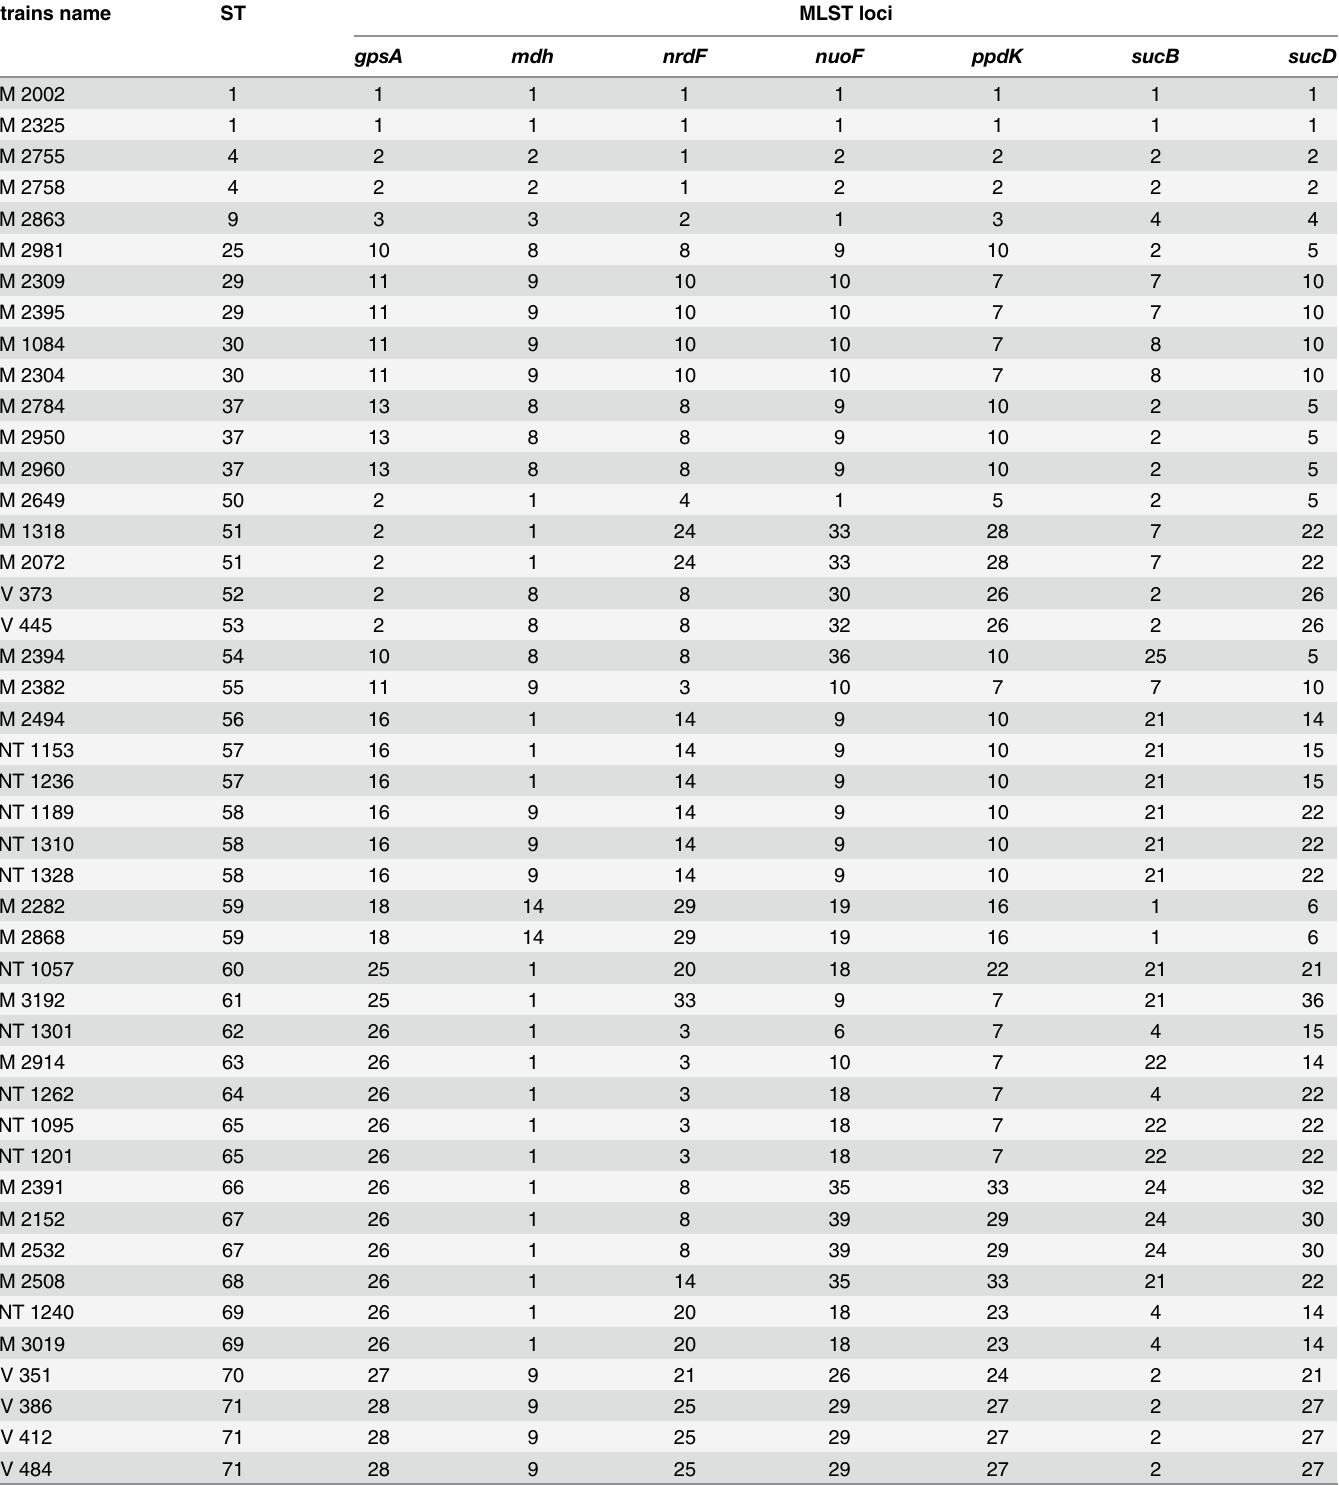
Table 3. Sequence type of 74 O . tsutsugamushi isolates from Laos. The strain name prefix TM indicates samples from Vientiane, LNT those from Luang Namtha, and SV those from